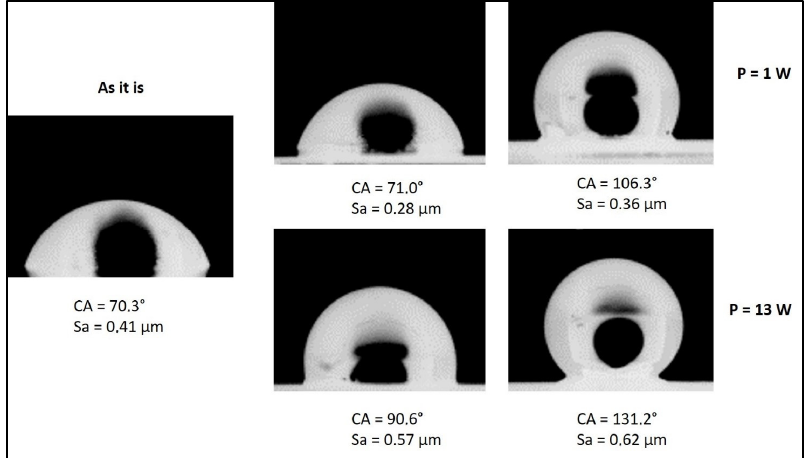
Figure 6. Contact angle of base material (as it is condition) and of samples treated at P = 1 W ( up ) and at P = 13 W ( down ).